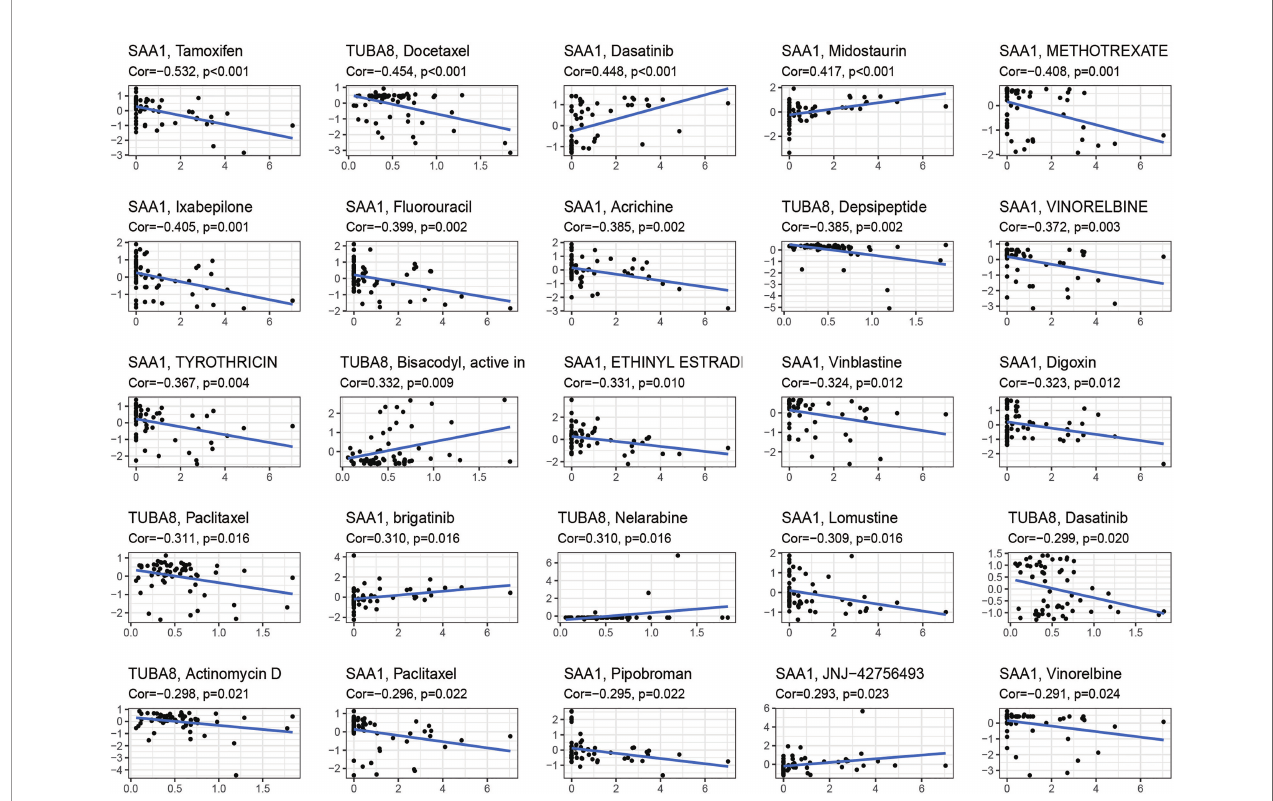
FIGURE 7 | Drug sensitivity analysis. The fi gure shows that SAA1 and TUBA8 showed different sensitivity correlations with a number of different drugs, respectively. If the correlation is positive, the higher the expression of this gene, the greater the sensitivity to the drug; if the correlation is negative, the lower the expression of this gene, the greater the sensitivity to the